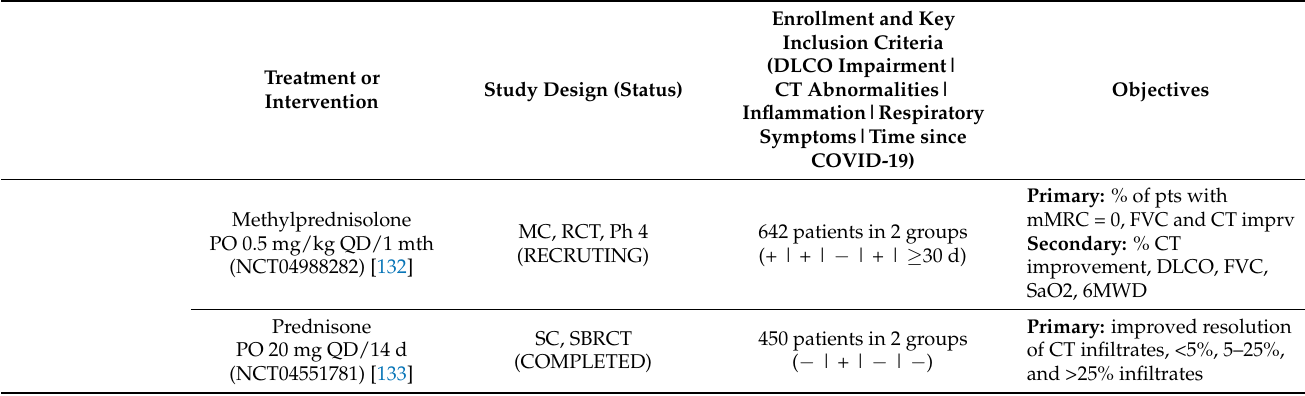
Table 2. Clinical trials for the treatment of OP-like